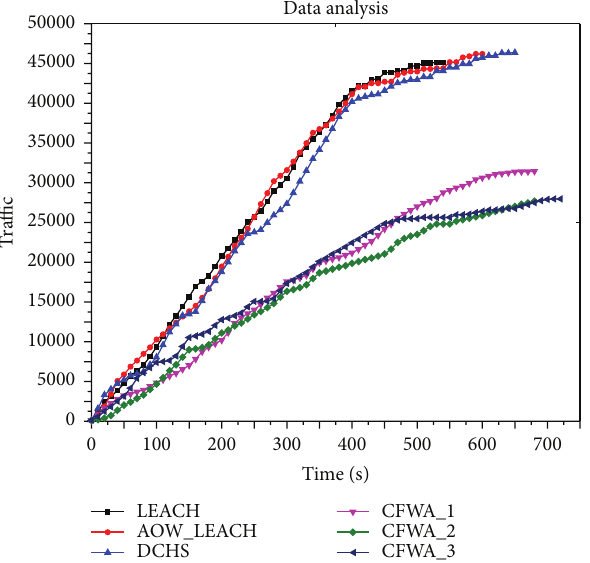
Figure 7: Traffic comparison diagram between CFWA family algorithms and LEACH-like algorithms in 100 nodes.